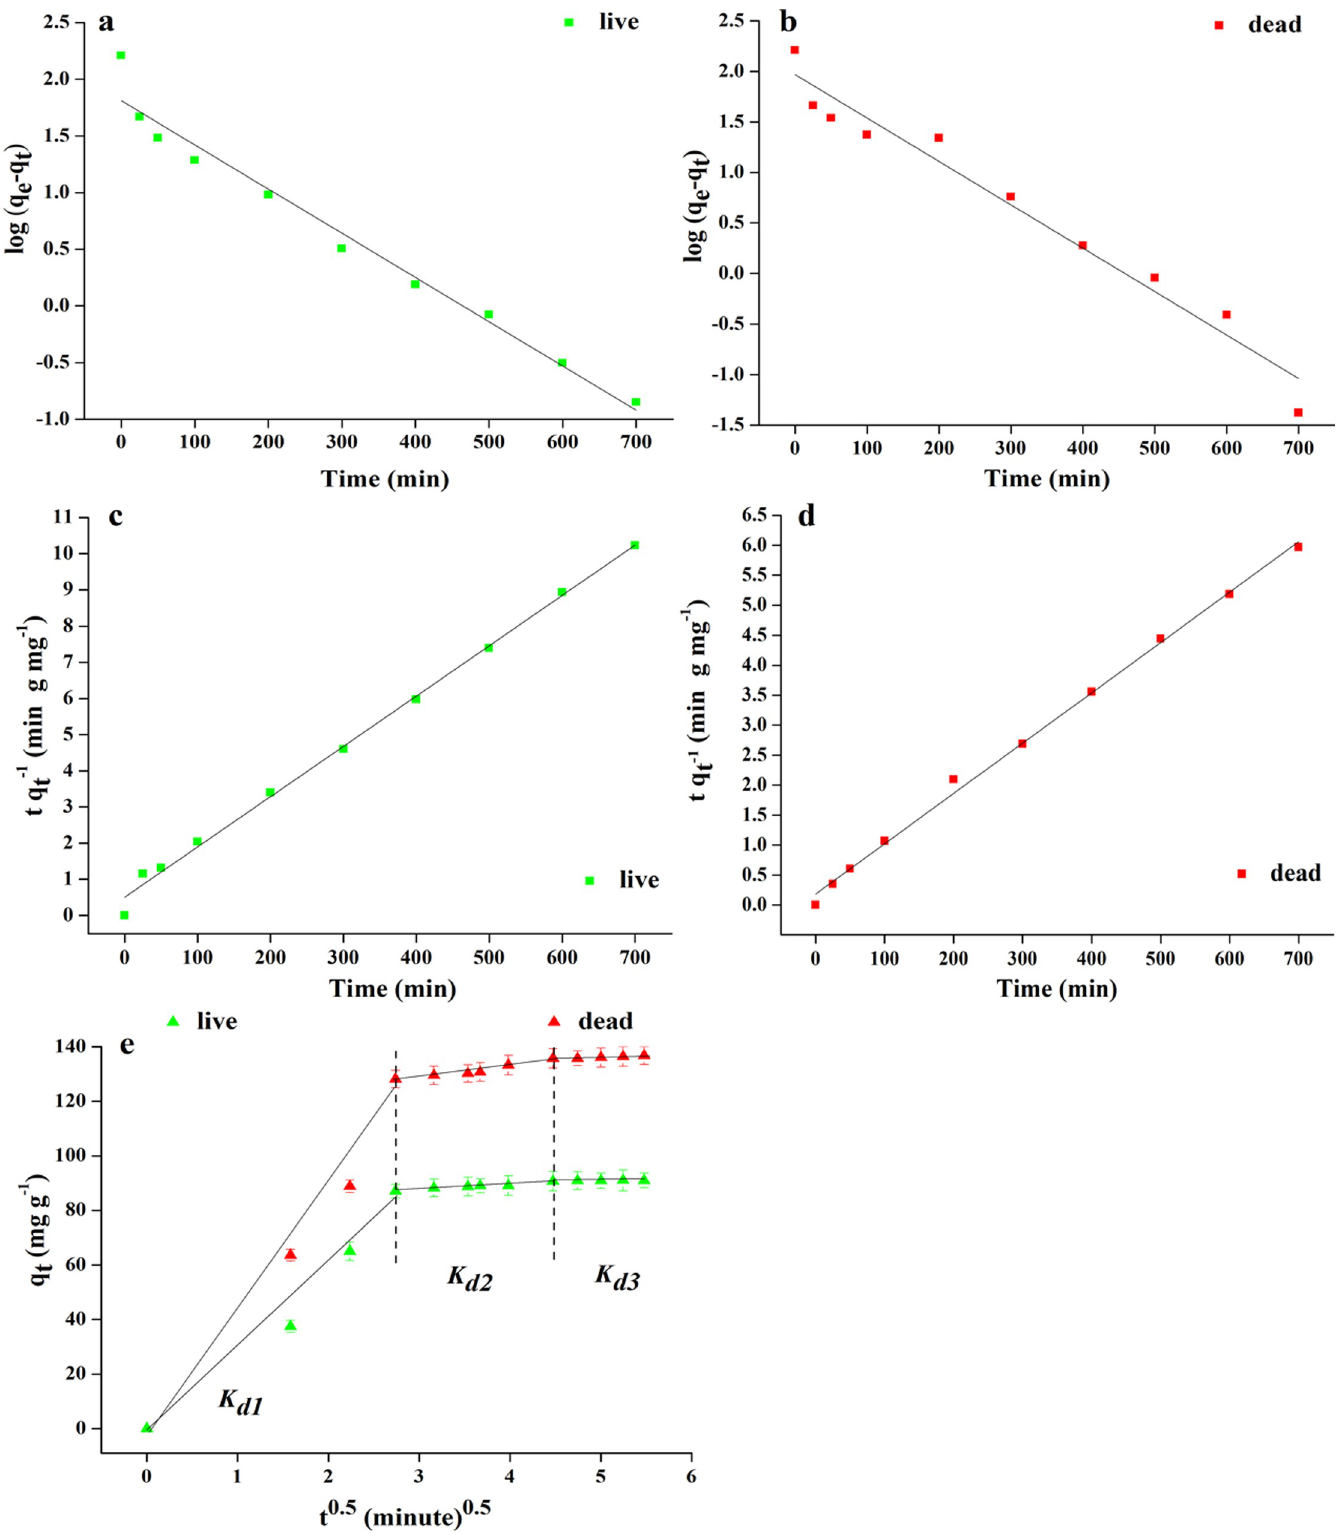
Fig 5. (a) Pseudo-first-order kinetics (live biosorbents) (b) Pseudo-first-order kinetics (dead biosorbents) (c) Second-order kinetics (live biosorbents) (d) Second-order kinetics (dead biosorbents) (e) Intra-particle diffusion kinetics for biosorption of heavy metal ions onto the live and dead biosorbents(T = 20˚C; biosorbent dose: 0.5 g L -1 ; pH 5; agitation speed: 200 rpm min -1